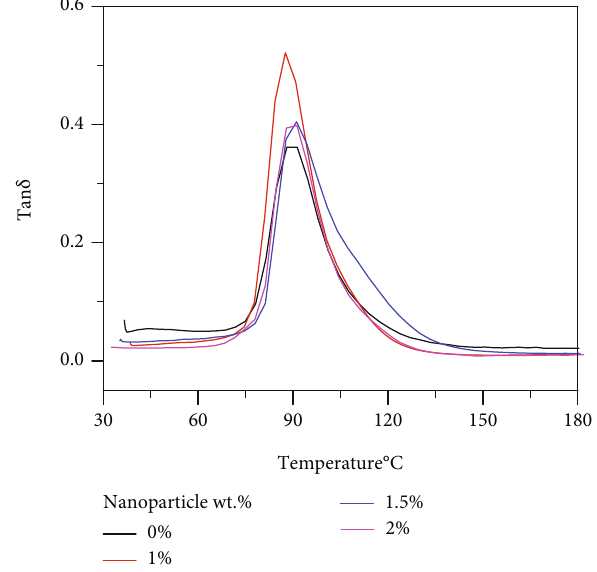
Figure 9: Tan δ vs. temperature plot for the epoxy nanocomposites.